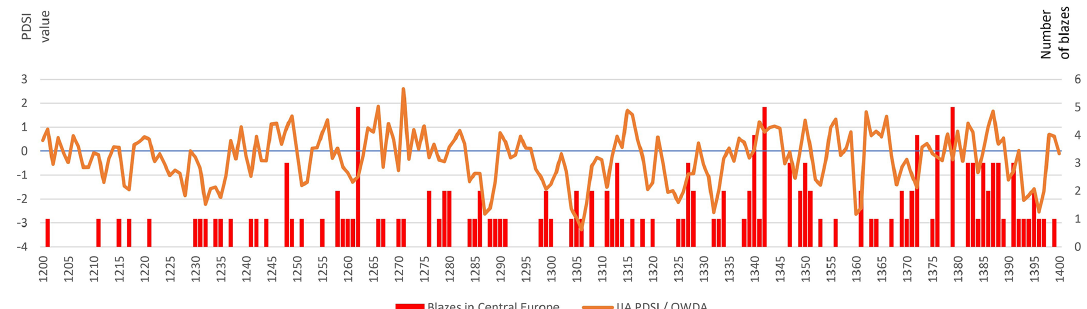
Figure 11. Reconstruction of JJA precipitation in tree rings for CE and information on fires from documentary data for the same